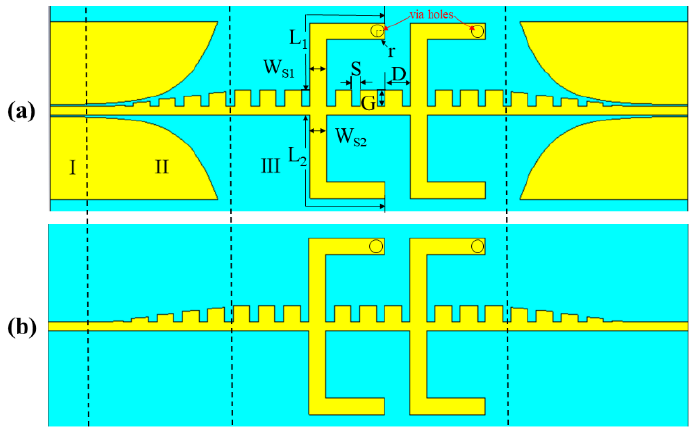
Figure 8. Schematic of the broadband filter with two combined-stub dual-mode resonators. ( a ) Up- layer schematic of the filter. ( b ) Down-layer schematic of the filter.